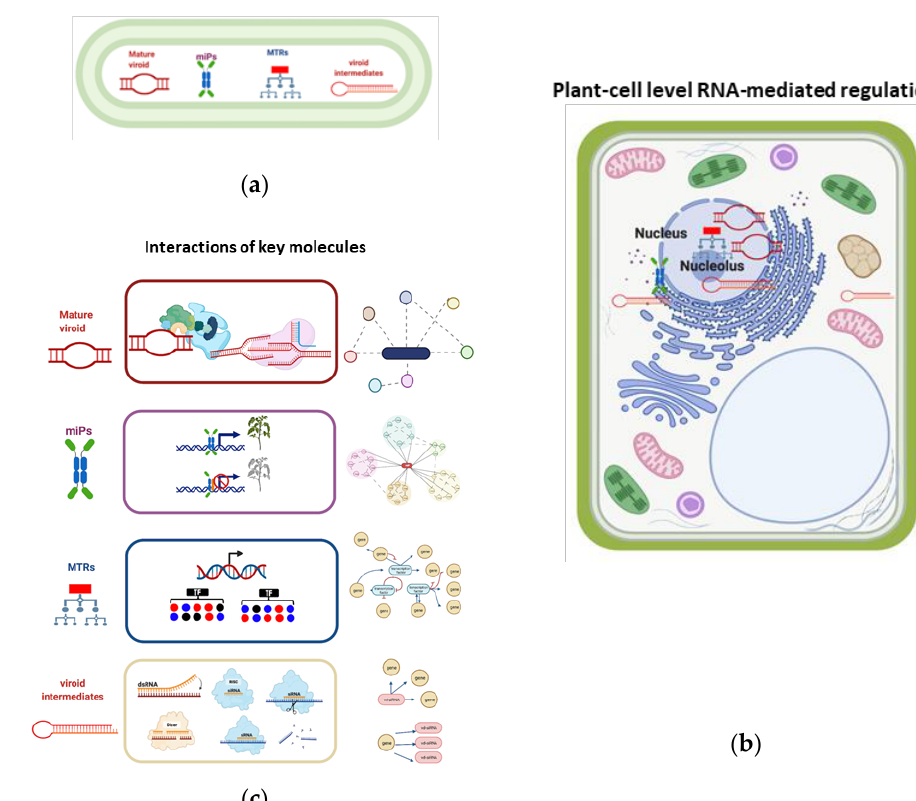
Figure 9. Network approaches to study viroid-host interactions. ( a ) Key molecules in viroid-host biology: mature viroid, microproteins, master transcriptional regulators, and viroid intermediates representation; ( b ) presence of mature viroid, miPs, MTRs, and vd-siRNAs as key biomolecules in plant cells and the location where they may be found; ( c ) potential network approaches to study interactomes of each type of molecule: mature viroid and its protein interactor, microProteins and their role in negative transcriptional regulation by protein-protein interactions in heterodimeric protein complexes, MTRs and their regulons in gene regulatory networks, and viroid intermediates and their mRNA targets. These strategies make it possible to have an insight into the complete mechanism of symptoms development in viroid hosts at different molecular levels. Illustration created with BioRender.com.